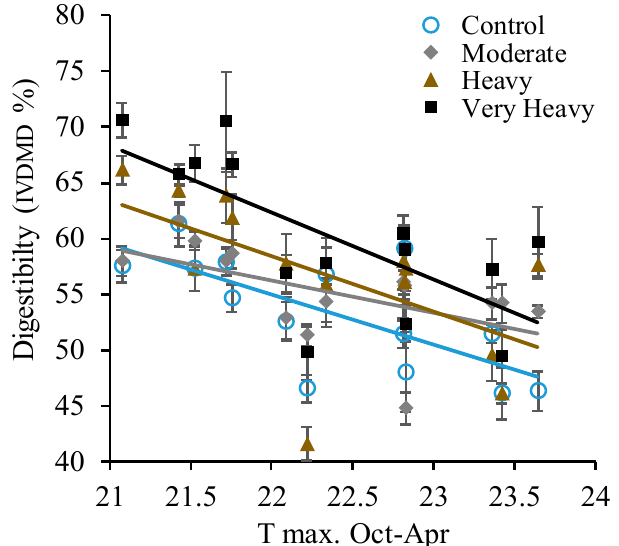
Figure 2. Relationship between the winter daily maximum temperature and in vitro dry matter digestibility (IVDMD) of herbage (%) under four grazing intensities. The winter daily maximum temperature was found to be the best predictor among the nine different climate variables tested. Data were collected annually at the Karei Deshe Experimental Range Station. Each point represents the average of six pooled samples (of six to eight samples each). The solid trend lines are significant at p ≤ 0.05.